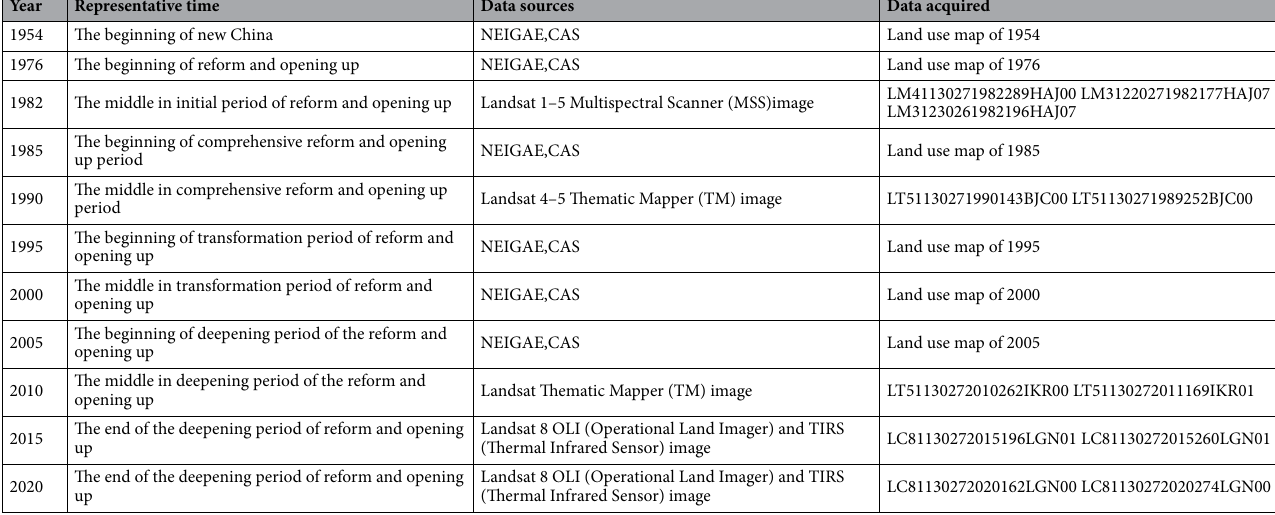
Table 1. Data description of land use data.